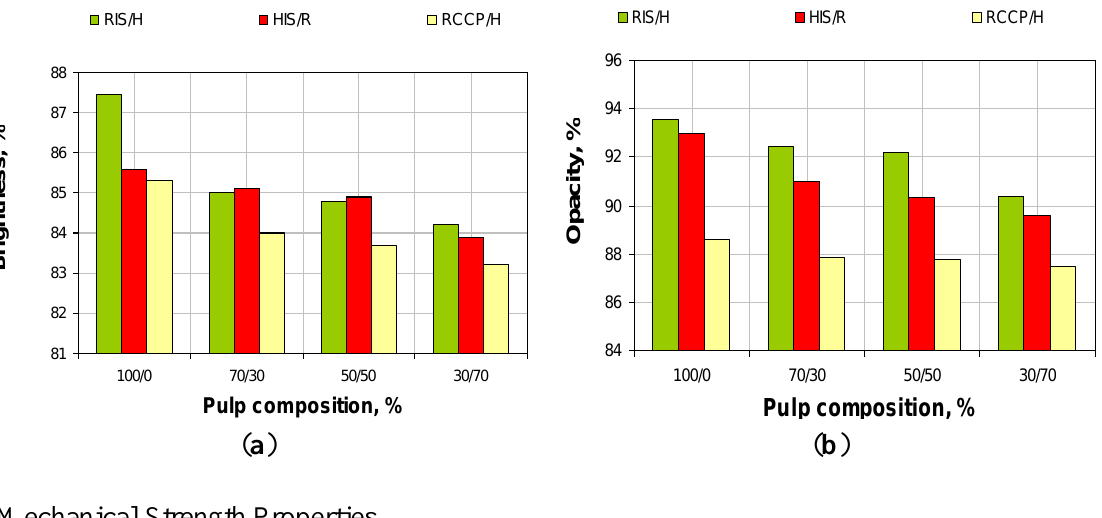
Figure 9. Evolution of properties in relation with pulp composition ( a ) brightness and ( b ) opacity.